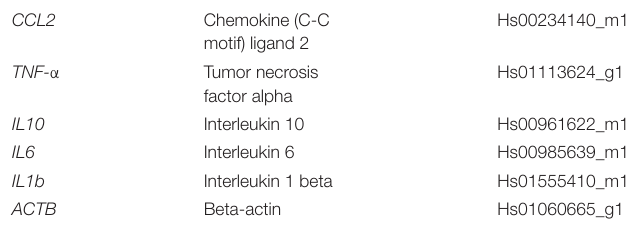
TABLE 2 | List of TaqMan assays used for qPCR